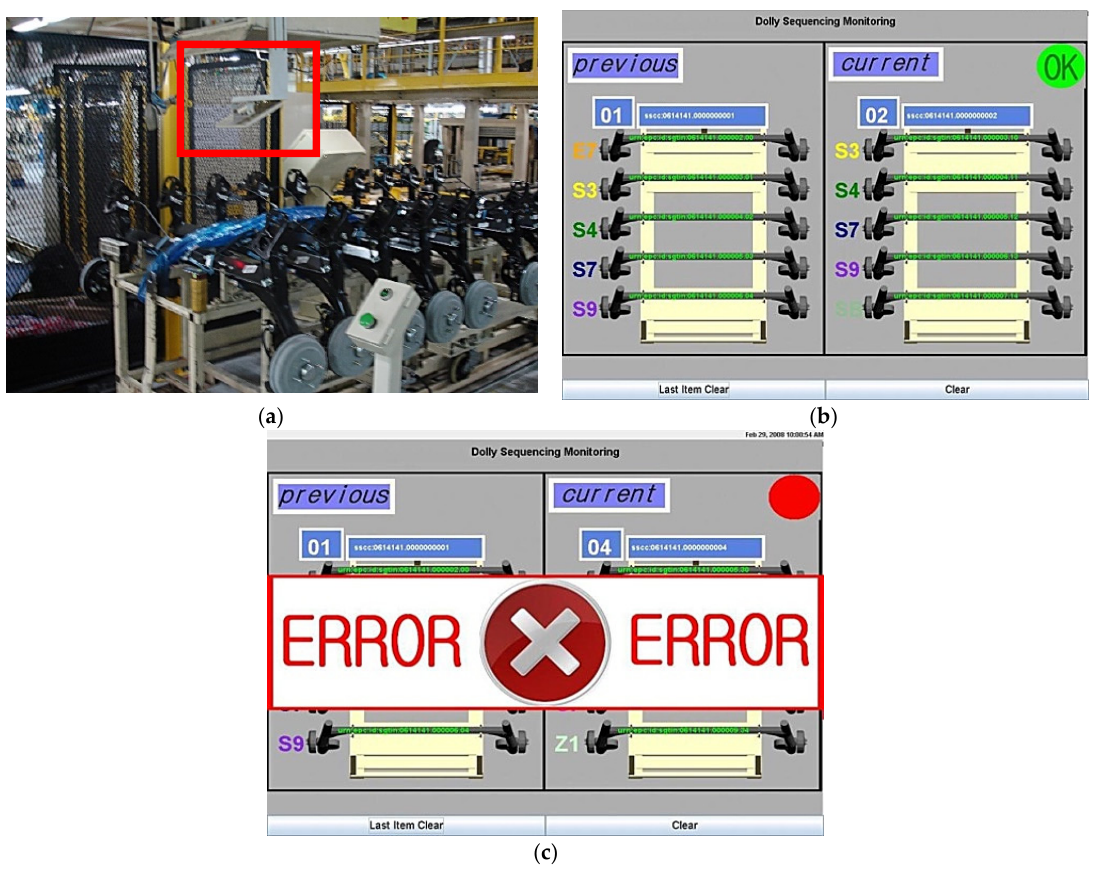
Figure 10. The sequencing process at the OEM. ( a ) Read point at feeding area; ( b ) Screen shot of dolly sequencing application in the case of no ‐ error; ( c ) Screen shot of dolly sequencing application in the case of sequencing ‐ error.